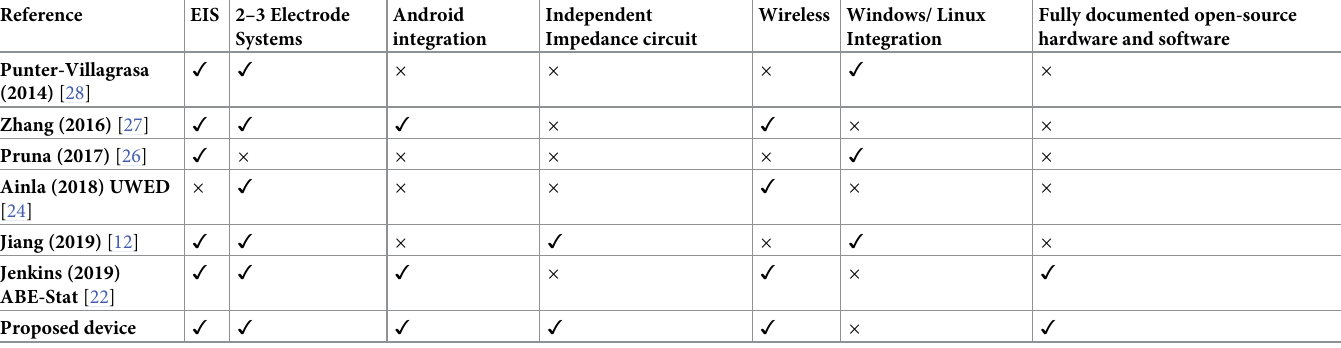
Table 1. Feature comparison of literature reviewed potentiostats with the proposed device.